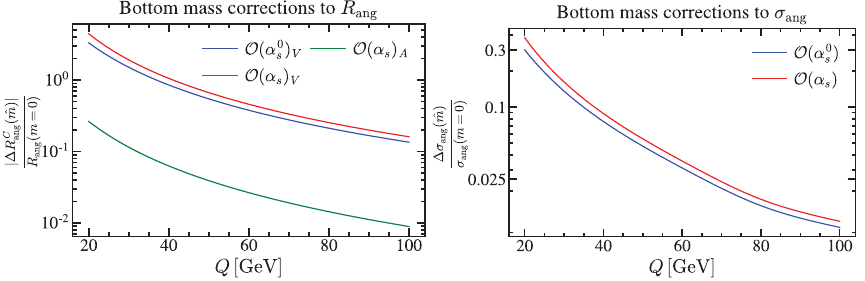
Figure 7: Bottom mass corrections to the total angular cross